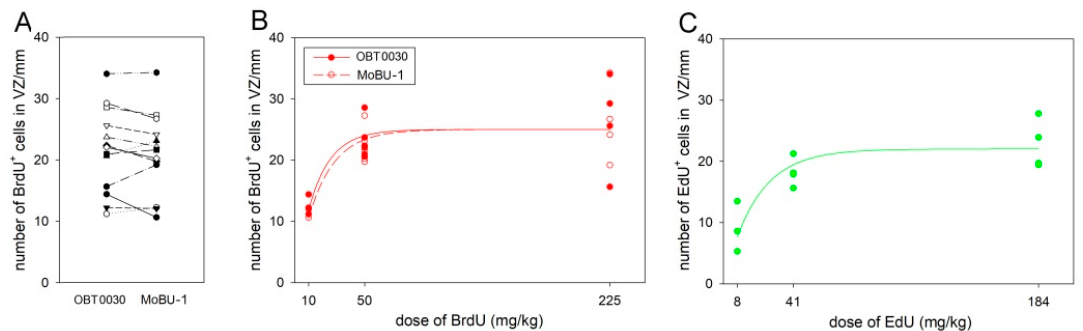
Figure 1. Comparison of two antibodies against BrdU ( A ) and saturation in the number of BrdU ( B ) and EdU ( C ) labeled cells in the VZ. ( A ) The number of BrdU + cells was obtained using two antibodies, OBT 0030 and MoBU-1. Each line connects the values from the same animal. ( C ) The doses of EdU are equimolar to the doses of BrdU (in B ). Each point represents an average number of labeled cells per mm length in one animal. BrdU showed saturation at higher dose than EdU.